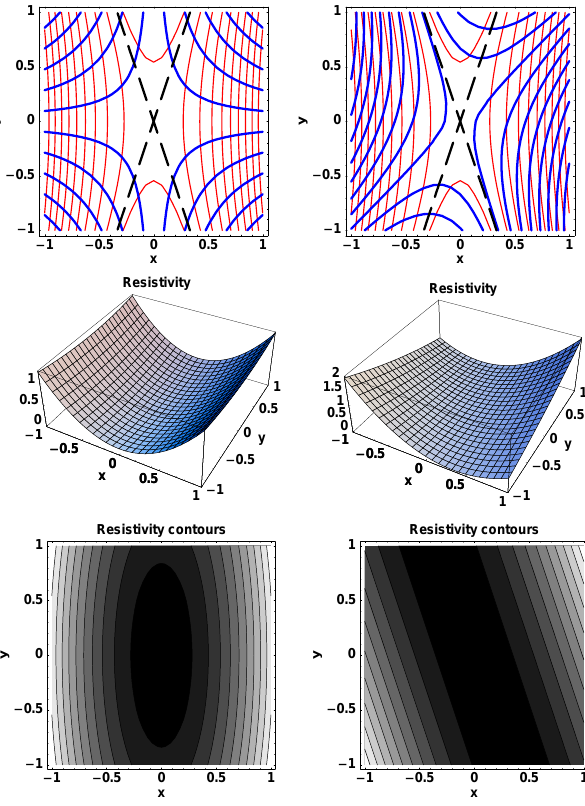
Fig. 2. Flow lines are thick (blue), thin (red) lines are magnetic field lines, thick (black) dashed lines are magnetic separatrix lines (top panels). Flow for the parameters V 11 = V 12 = 1 and s = 0 (left column), crossing all four magnetic separatrix branches (left top panel), and s = − 1 (right column), flow lines crossing only two magnetic separatrix branches (right top panel), shape of the posi- tive resistivity η 0 (middle panels), and the elliptic shaped contours of the resistivity (bottom